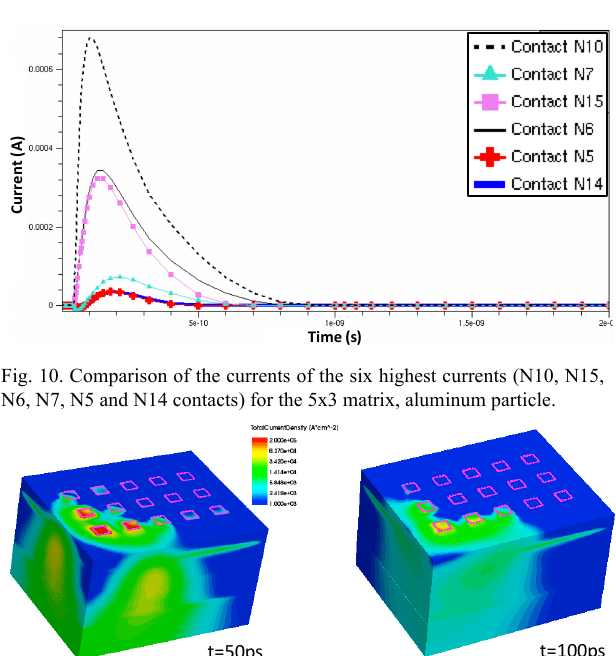
Fig. 11. Total current density at t=50ps (maximum of the generation) and t=100ps for the aluminum particle.